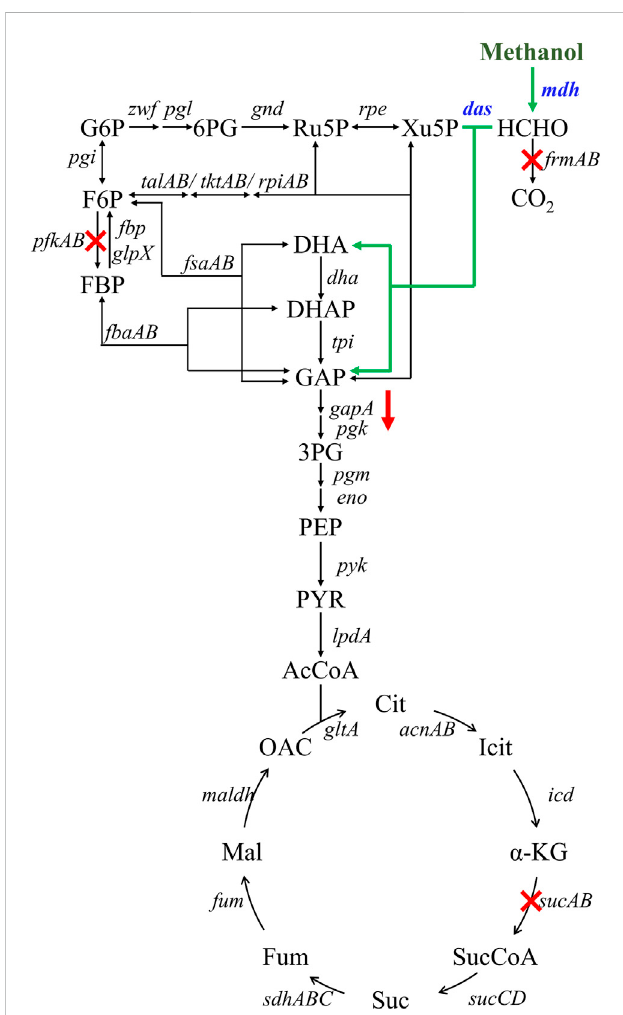
Engineering strategies for improving methanol assimilation based on a hybrid methanol assimilation pathway. The symbol ‘‘ X ’’ indicates gene deletion and the symbol ‘‘ ↓ ’’ indicates down-regulation of gapA gene. Abbreviations: G6P: glucose-6-phosphate; 6PG: 6- phosphogluconate; Ru5P: ribulose-5-phosphate; Xu5P: xylulose 5- phosphate;F6P:fructose-6-phosphate;FBP:fructose-1,6-diphosphate; DHA: dihydroxyacetone; DHAP: dihydroxyacetone phosphate; GAP: glyceraldehyde-3-phosphate; 3PG: glycerate-3-phosphate;